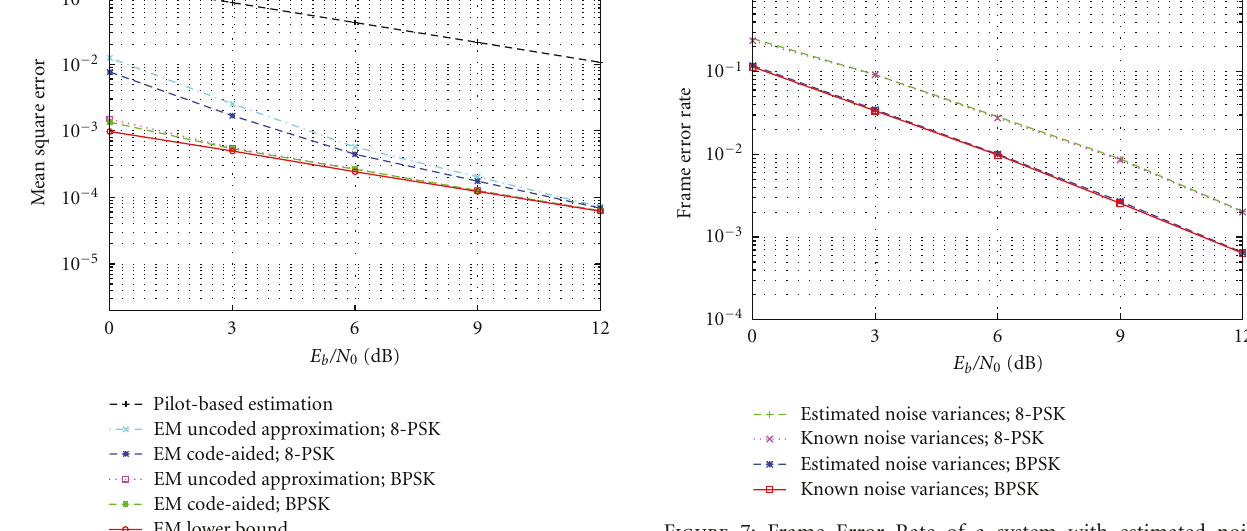
Figure 7: Frame Error Rate of a system with estimated noise variances, compared to a system with known noise variances, for both BPSK and 8-PSK